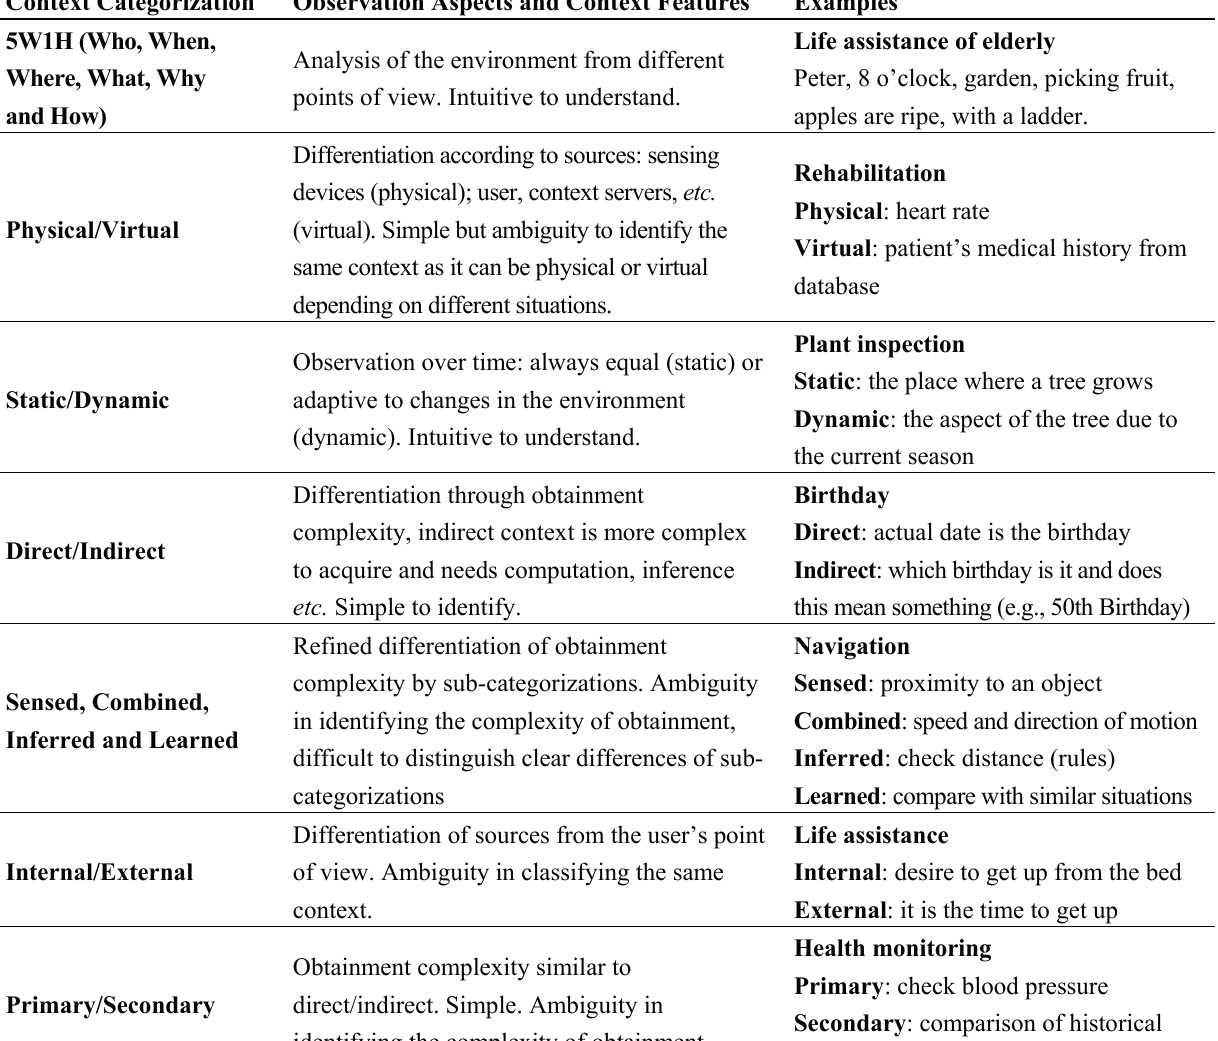
Table 1. Context